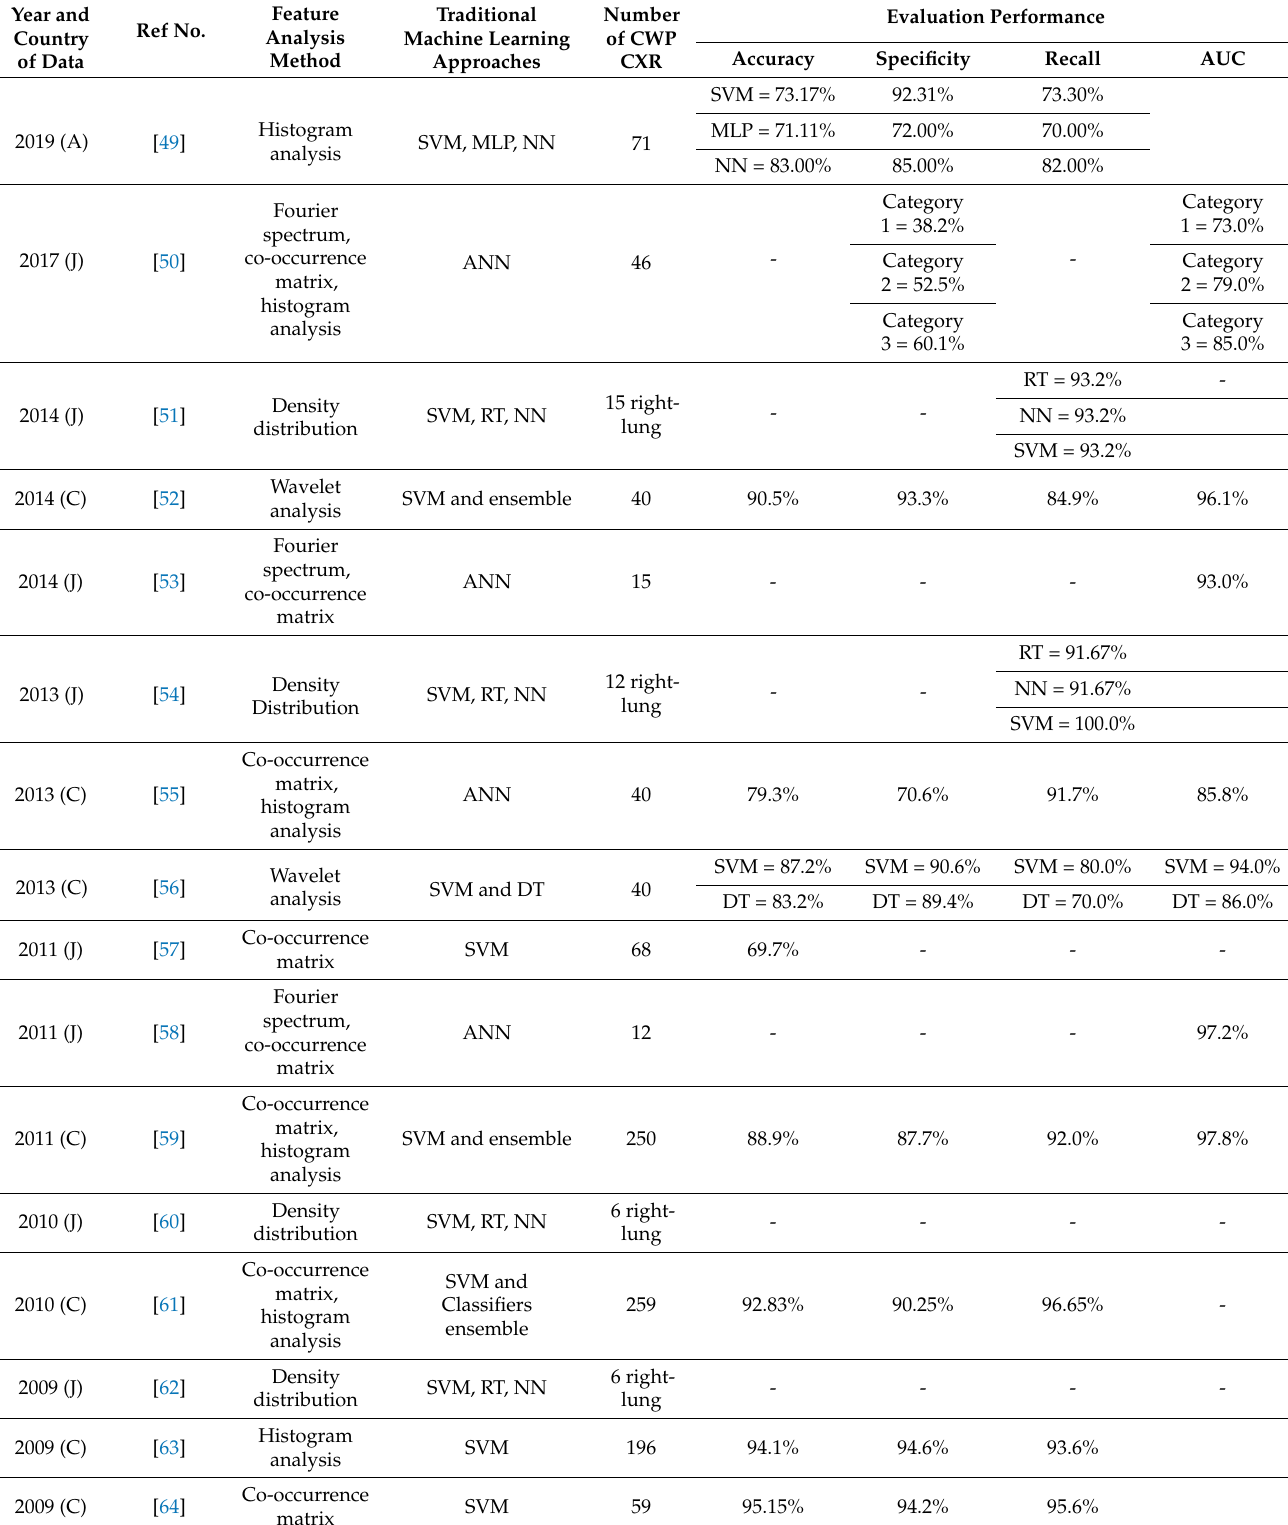
Table 3. Summary of traditional machine learning approaches included